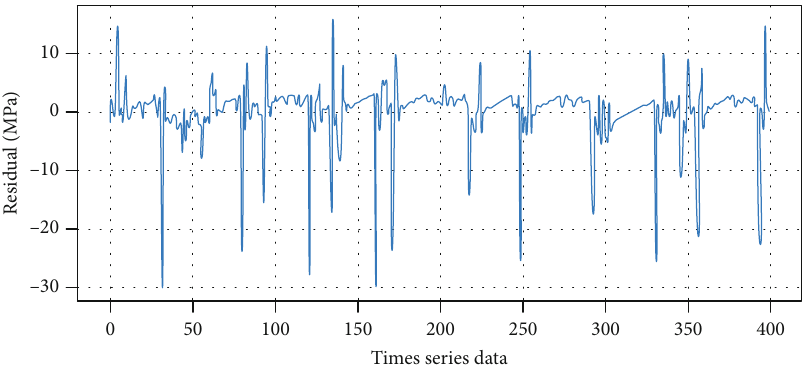
(b) Results of BIC with various model parameters Figure 6: AIC and BIC values of di ff erent model parameters.